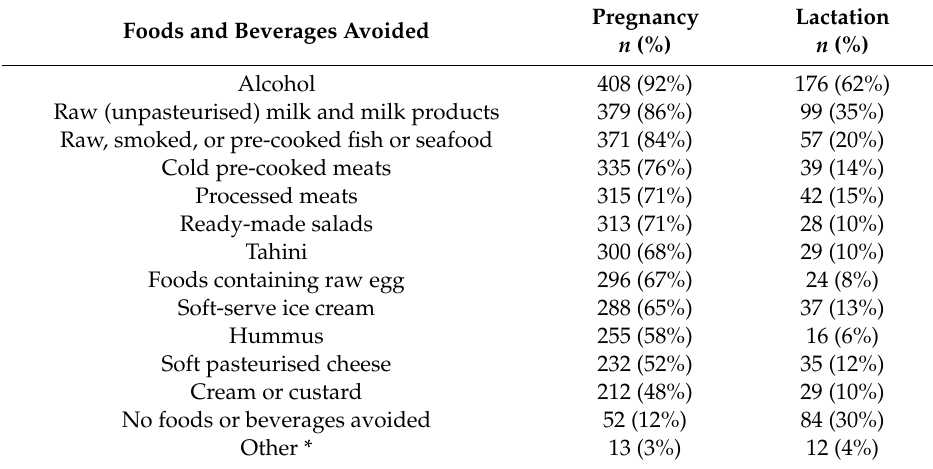
Table 5. Foods limited in the diet during pregnancy and lactation. Foods Limited in Diet Pregnancy n (%) Lactation n (%) Canned fish 160 (36%) 36 (13%) Blu ff or Pacific oysters, or Queen scallops 136 (31%) 43 (15%) Longer lived and larger fish 130 (29%) 30 (11%) 128 (29%) 33 (12%) Brown seaweed 128 (29%) 37 (13%) 85 (19%) 97 (34%) Choose not to answer 17 (4%) 8